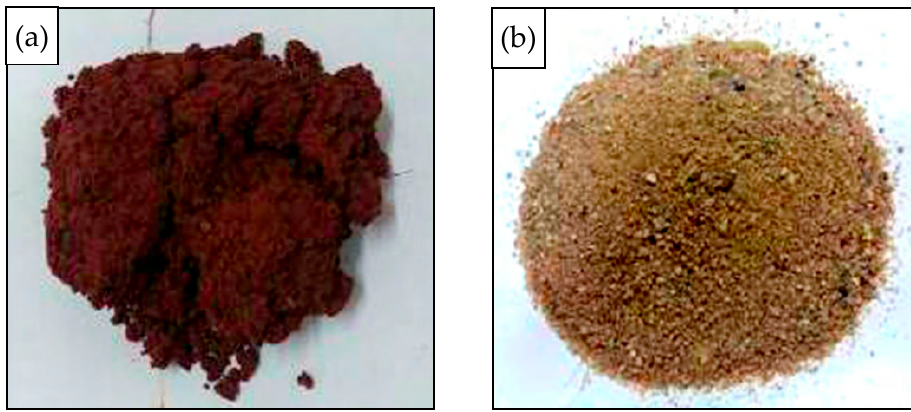
Figure 2. Typical appearance of sandy and clayey soil. ( a ) Clayey soil. ( b ) Sandy soil. Table 1. Unsaturated parameter values.